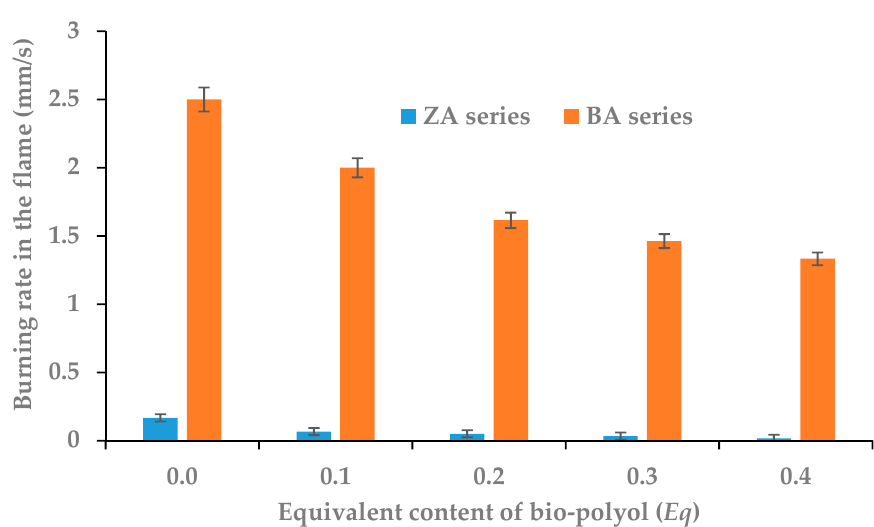
Figure 8. Dependence between bio-polyol content and burning rate in flame (BR).